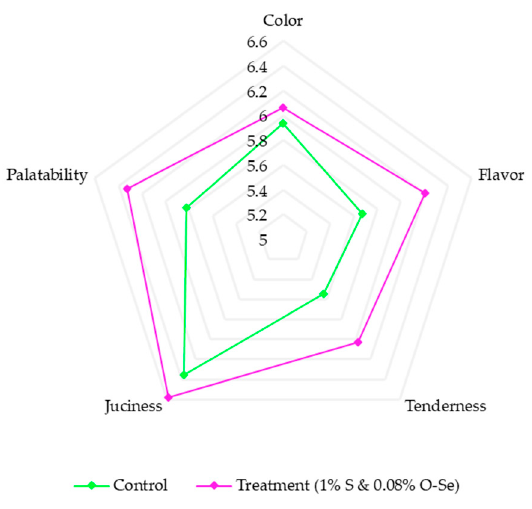
Figure 4. Effect of stevioside and organic selenium on meat sensory attributes of Hanwoo cattle.